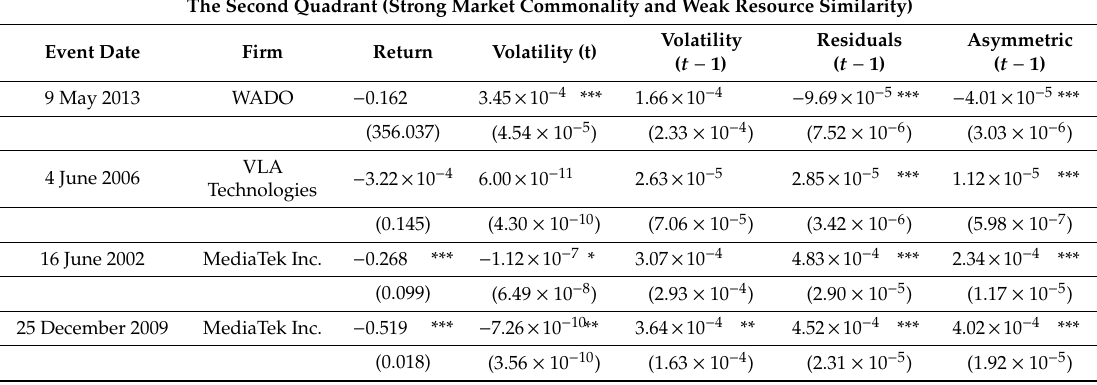
Table 4. Second quadrant estimation results of GJR-GARCH after projection of dynamic